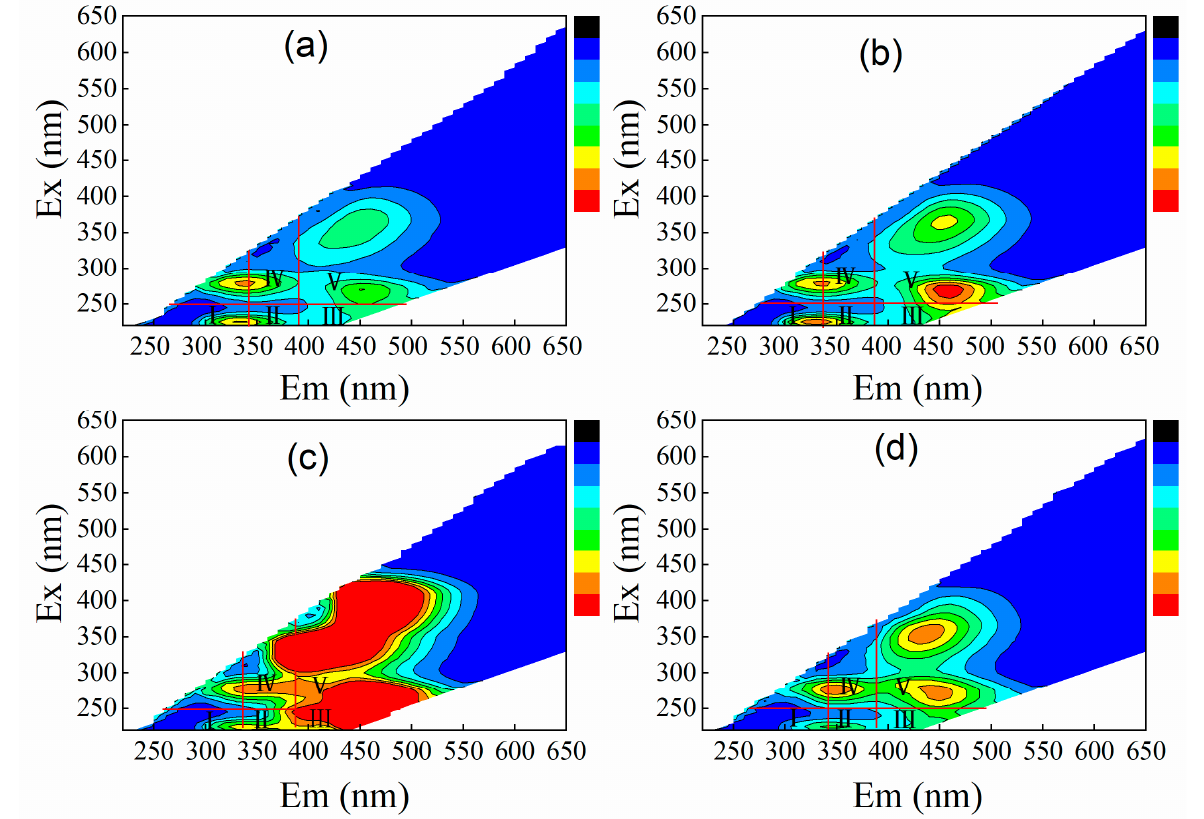
Figure 5. Variations of organic composition in the wastewater before ( a ) and after treatment by PVC ( b ), PP ( c ), and PET ( d ) MPs.